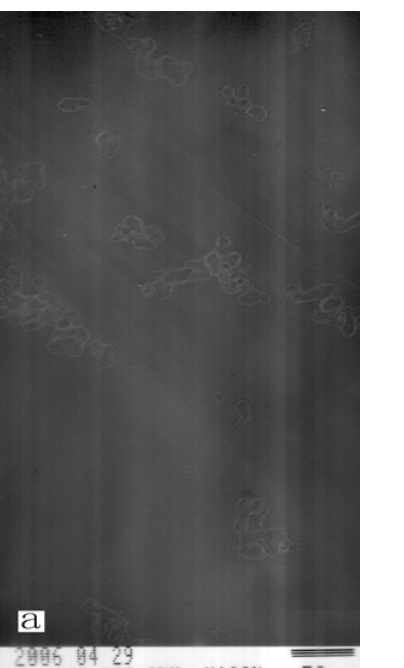
Figure 4. TEM spectra of different sizes of CuO.